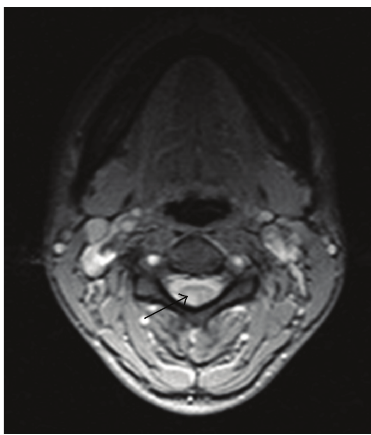
Figure 1: MRI 1.5T Axial section obtained with sequence GRE-T2 at C4 level showing a signal hyperintensity of posterior